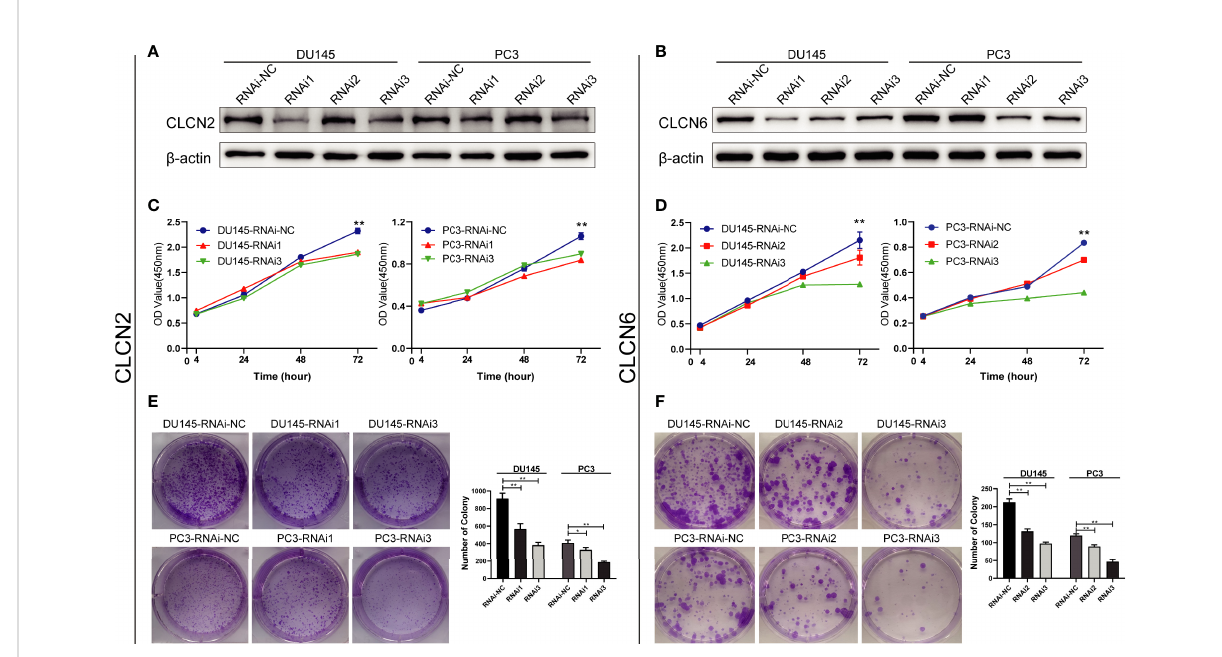
FIGURE 10 Downregulation of CLCN2 or CLCN6 inhibited cell proliferation and colony formation. WB assay of (A) CLCN2 or (B) CLCN6 downregulation ef fi ciency. Downregulation of (C, E) CLCN2 or (D, F) CLCN6 suppressed cell proliferation and colony formation based on CCK-8 and colony formation analysis. * p<0.05 and ** p<0.01.